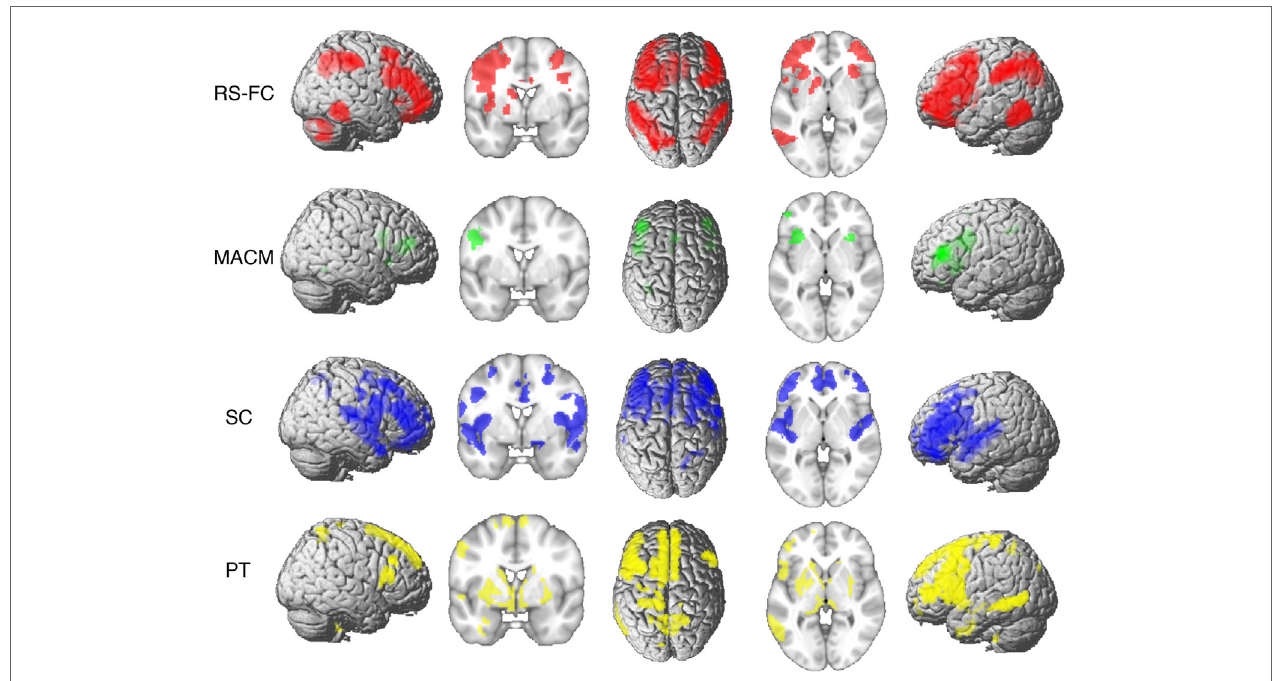
FigUre 4 | Brain regions found to be significantly connected with the seed for each modality at p < 0.05, FWe corrected for multiple comparisons using threshold-free cluster enhancement (TFce statistic)